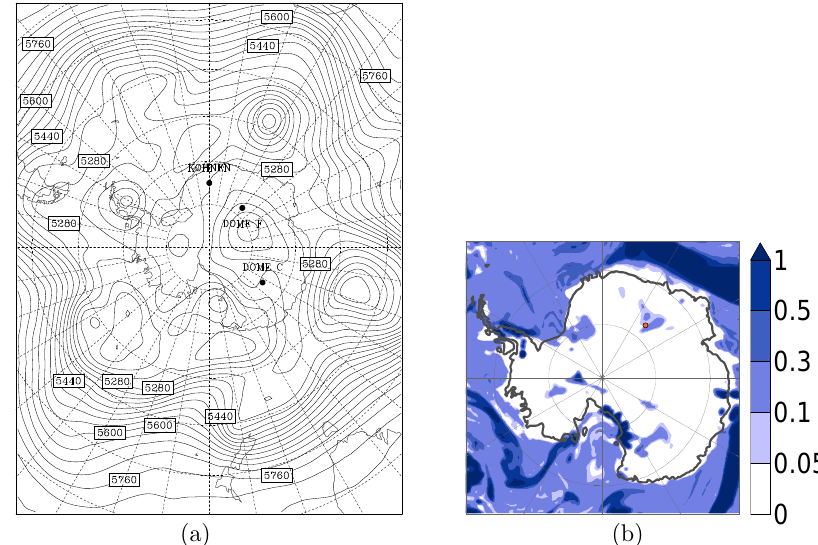
Figure 9. Example for the event type Previous Precipitation Event; (a) 500hPa geopotential height from AMPS, 14 December 2003 00:00UTC, (b) 6h precipitation in mm from AMPS, 14 December 2003